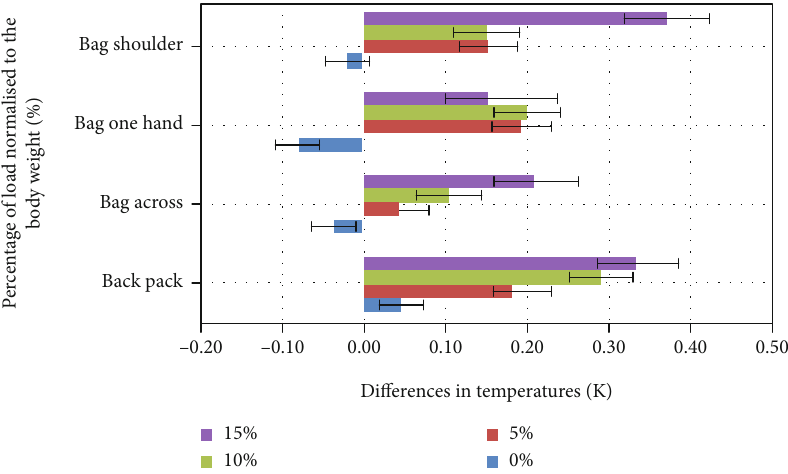
Figure 5: Average di ff erences for obliquus abdominis in the function of normalized